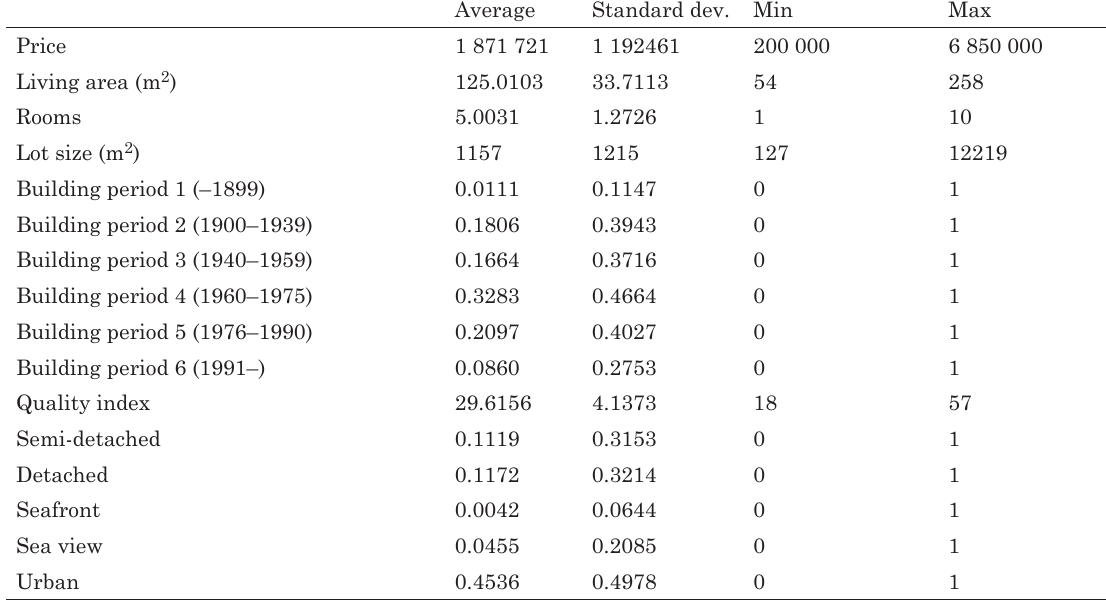
Figure 2. Number of transactions per capita (100 Table 1. Descriptive statistics concerning attributes that are used in the hedonic price equation (data observed during 2005–2010)